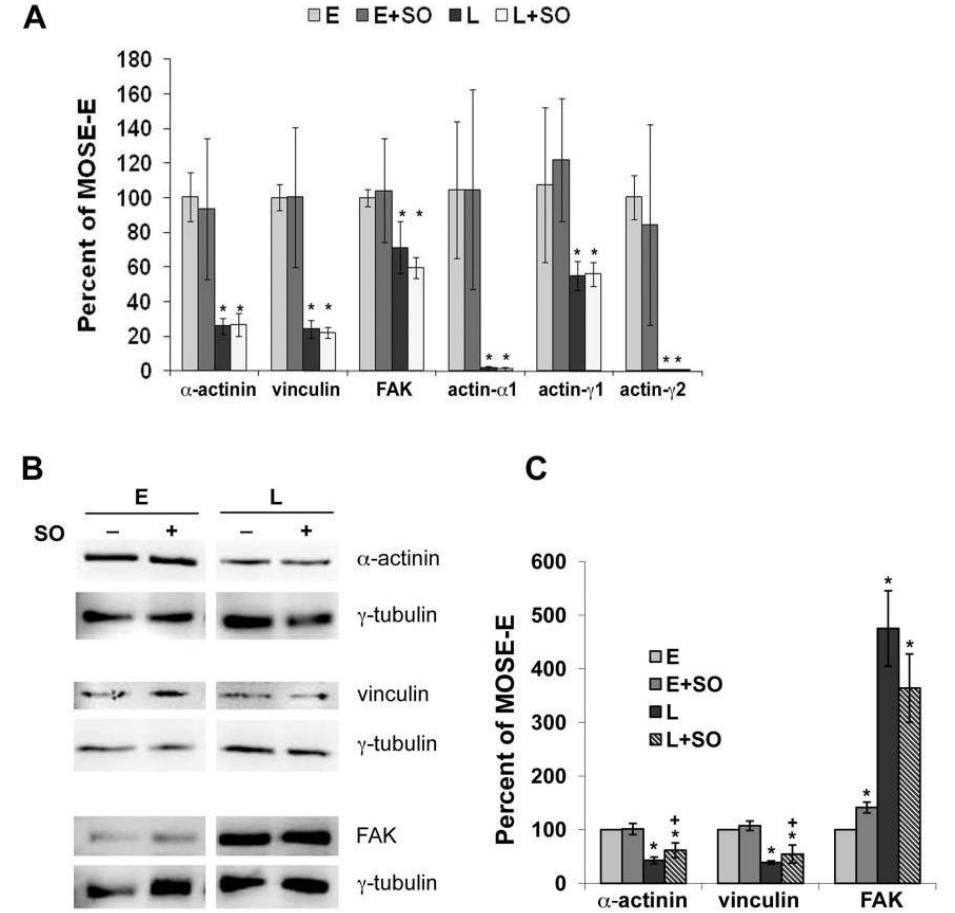
Figure 2. Sph treatment affects protein but not mRNA levels of cytoskeleton genes and regulators in MOSE cells. MOSE-E and MOSE–L cells were passaged three times in the absence or presence of 1.5  M So. ( A ) Real-time PCR analyses of changes in mRNA levels of select cytoskeleton genes. *significantly different from MOSE-E, p < 0.05; ( B ) Representative Western blot of MOSE cells treated with So; and ( C ) quantitated using  -tubulin as housekeeping protein; expressed as percent of MOSE-E levels  SD. *significantly different from untreated MOSE-E, p  0.05; + significantly different from corresponding untreated controls, p 